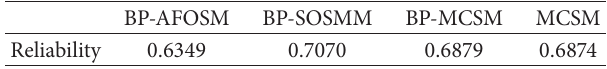
Table 2: Comparison of the reliabilities obtained using the different